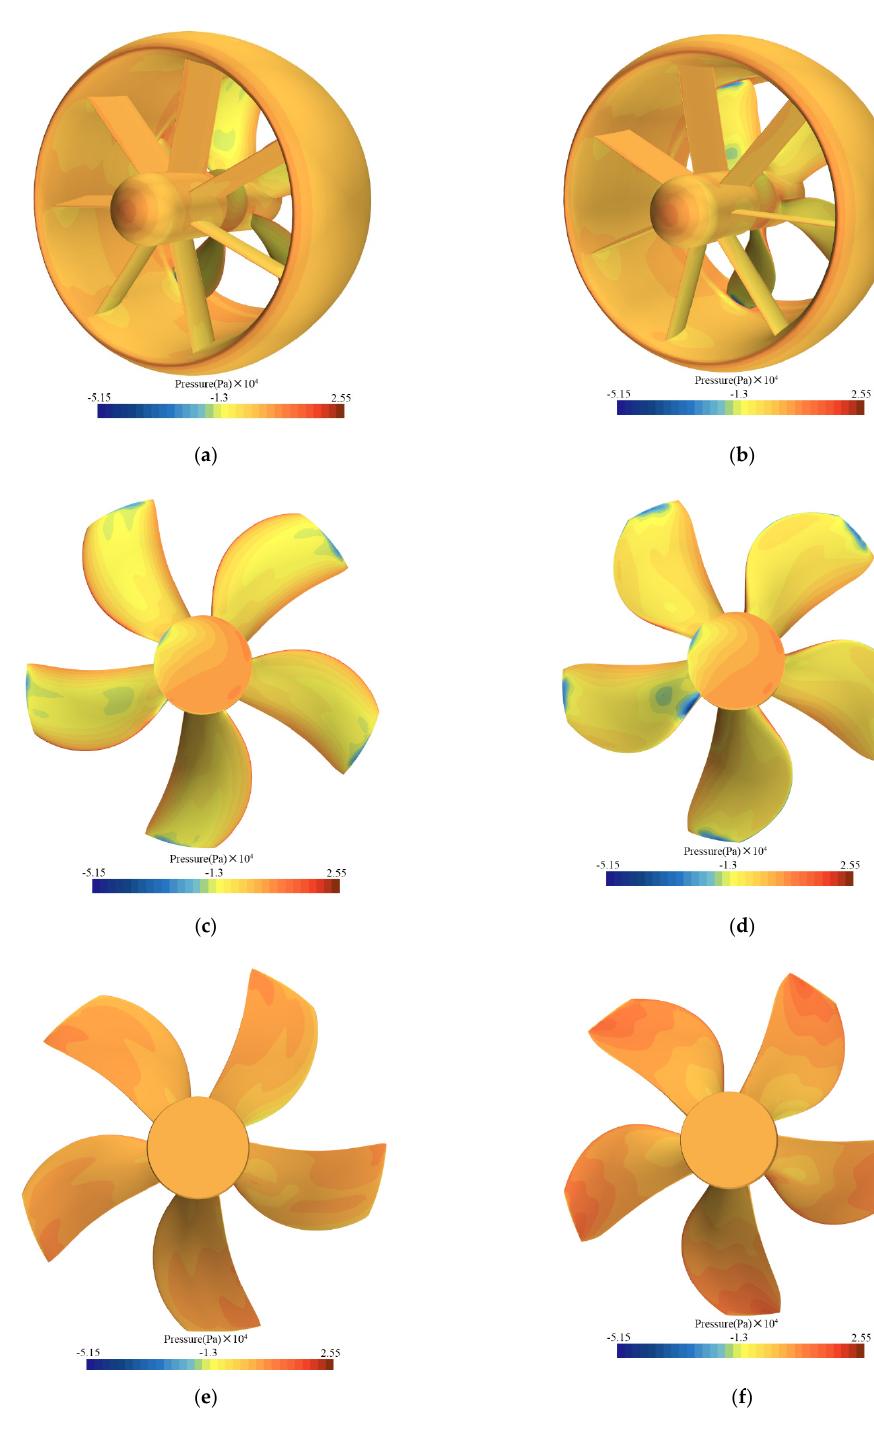
Figure 18. Comparison of the surface pressure between the parent pump-jet propulsion system and the optimized pump-jet propulsion system: ( a ) surface pressure of parent pump-jet propulsion system; ( b ) surface pressure of optimized pump-jet propulsion system; ( c ) surface pressure on the back surface parent of pump-jet propulsion system; ( d ) surface pressure on the back surface parent of optimized pump-jet propulsion system; ( e ) surface pressure on the front surface parent of parent pump-jet propulsion system; ( f ) surface pressure on the front surface of optimized pump-jet propulsion